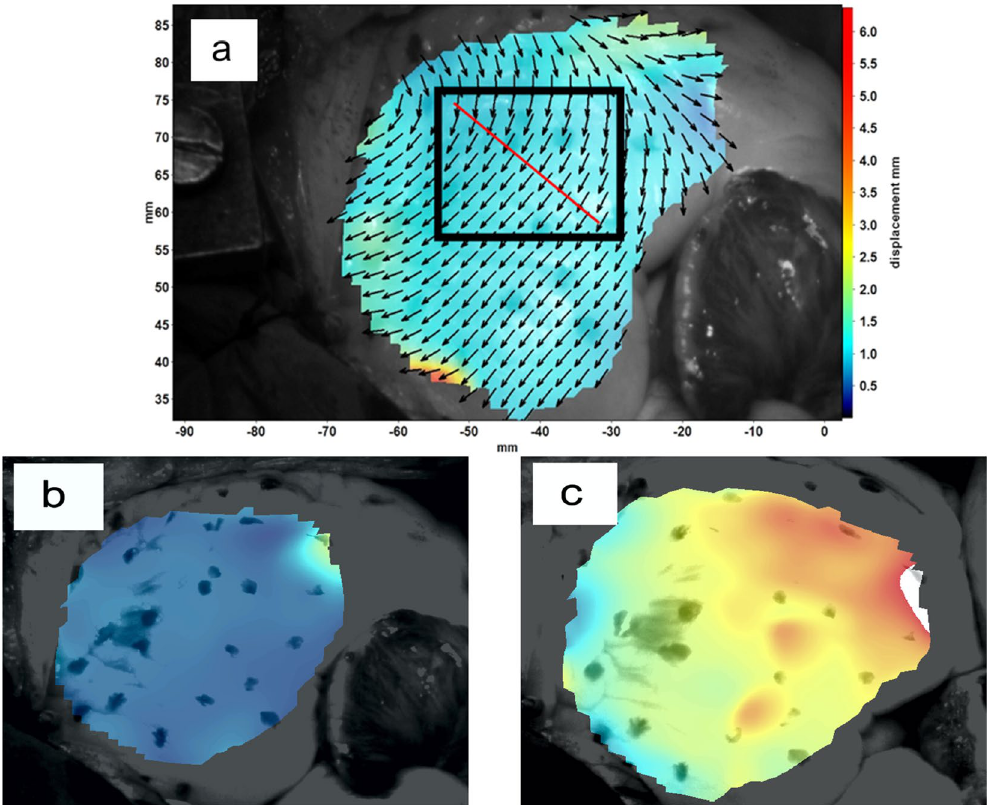
Figure 3. ( a ) Original image from the heart overlain with displacement vectors and the vector length indicated by the colors. The black rectangle indicates where the average of the vector components, strain rate, principal strains, and tissue velocity were obtained from, and the red line shows the direction and length of the virtual extensometer used for extracting the data for fractional shortening ( b ) Displacement color heat maps for early systole stage ( c ) Displacement color heat maps for end diastole